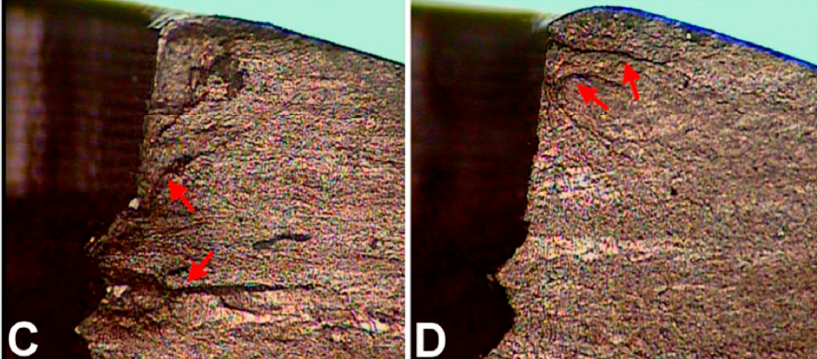
Figure 2. Optical microscopic images of fracture surfaces. There are three zones indicating fatigue fracture ( A , B ) and the magnified views of the crack initiation sites ( C , D ). C represents the crack initiation zone. P represents the crack propagation zone. O represents the final overloading zone. Red arrows point to the crack lines. Yellow arrows point to the machining lines at the screw holes. (according to [6]).